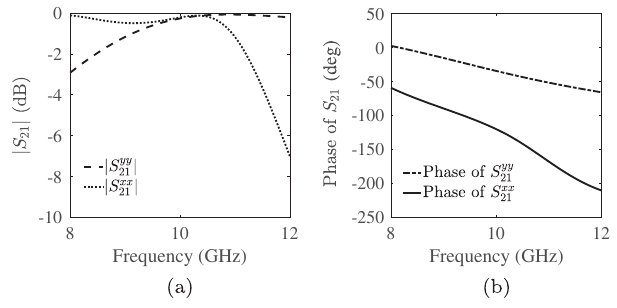
FIG. 17. On-axis simulation results of the designed QWP. (a) Amplitude and (b) phase of transmission coefficients for x and y polarizations.